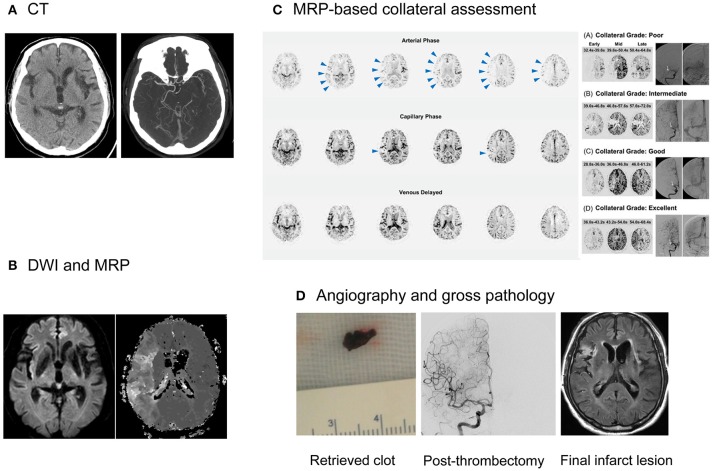
Collateral imaging-based delayed endovascular treatment. A 79-year-old female, with history of left MCA infarction and atrial fibrillation, presented with left-sided weakness and neglect symptoms at 940 min after symptom onset. (A) CT imaging documented right MCA occlusion, with an ASPECTS of 8. (B) MRI showed a significant mismatch, with a small core and large hypoperfusion regions. (C) MRP-based collateral imaging showed an excellent collateral flow, i.e., complete and rapid collateral flow to the vascular bed in the occluded MCA territory. Contrast staining in the lesional hemisphere was absent in the arterial phase (arrowheads), but evident in the capillary and venous phase. (D) Successful recanalization (mTICI grade 2b) was achieved and red clots were retrieved at the first passage of a stentriever at 1,090 min after the onset of symptoms. She was functionally independent and her modified Rankin score at the 90th day was 1. MCA, middle cerebral artery; CT, computed tomography; ASPECT, Alberta stroke program early CT Score; MRI, magnetic resonance imaging; DWI, diffusion-weighted imaging; MRP, MR perfusion; mTICI, modified treatment in cerebral ischemia.